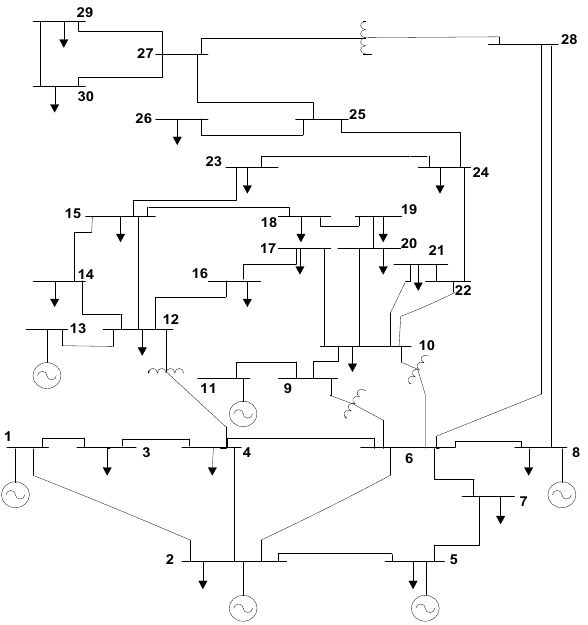
Figure 2. Single line diagram of IEEE 30-bus test system. Table 1 summarizes all AGTLBO’s optimal options for the 30-bus power grid. Table 1. Optimal control variables at the lowest cost (best solution) for each test case. Control Variables Settings